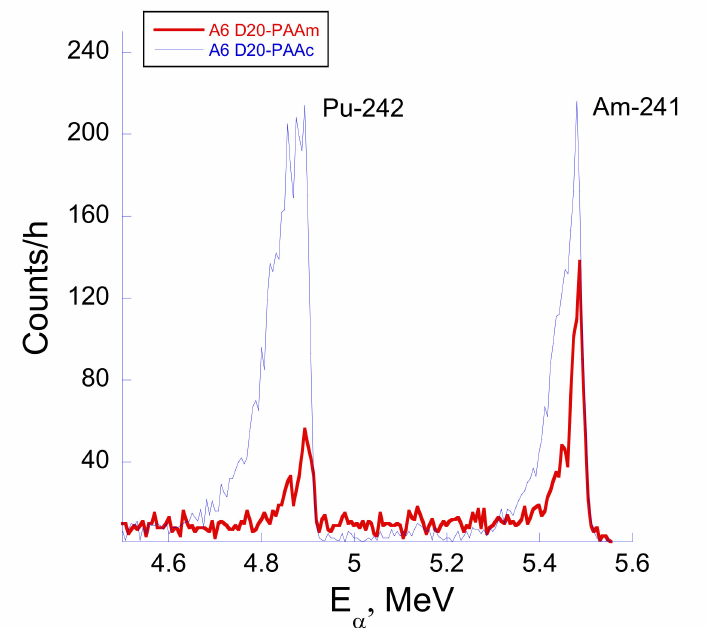
Figure 6. Example alpha spectra of PVDF-A6 membrane with D20-PAAm (or D20-PAAc) layer on top after deposition of 242 Pu from aqueous solution in Approach 2. The estimated ratios of integral intensities of the two peaks are I Pu-242 /I Am-241 for D20-PAAm and D20-PAAc are 0.77 and 1.6,